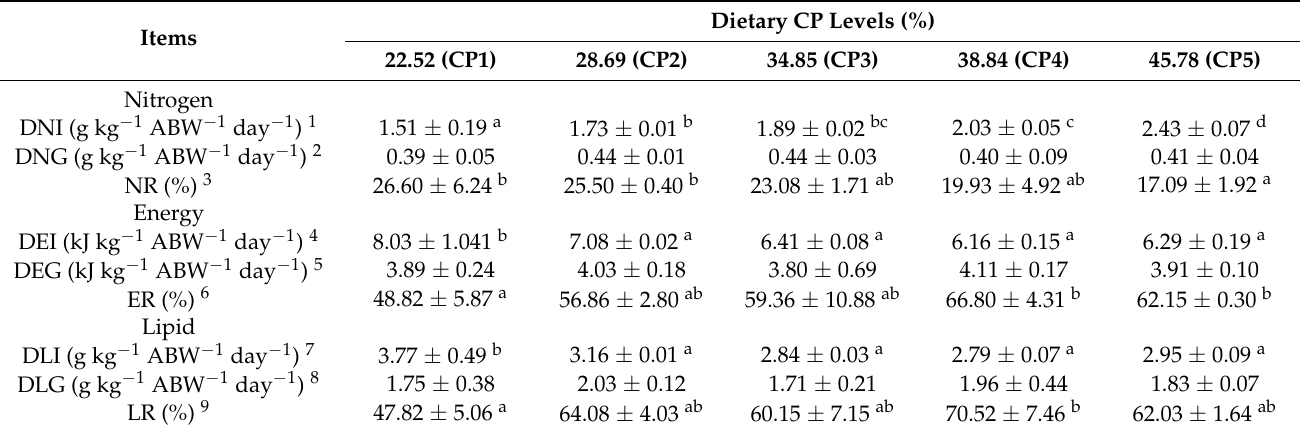
Table 3. Nitrogen, energy, and lipid utilization by juvenile K. punctatus fed diets containing different CP levels.